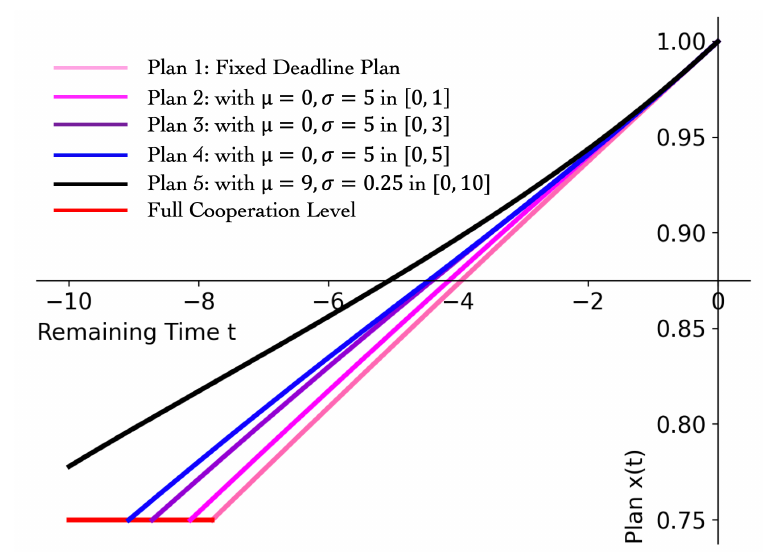
Figure 2. Plans for Cournot game with various deadline